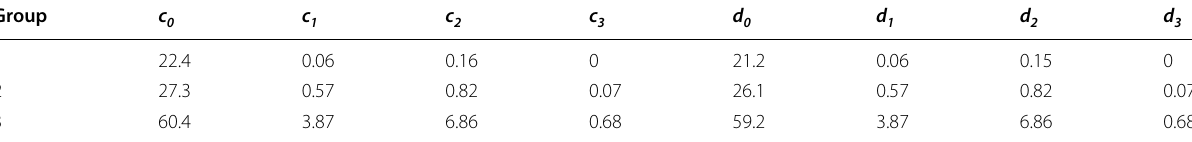
Table 5 Bone-quality coefficients for thread-forming